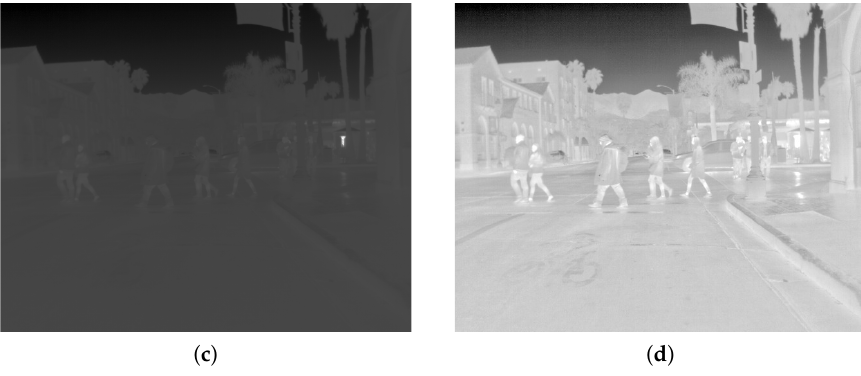
Figure 3. ( a ) Result 1 without multiscale guided filter enhancement. ( b ) Result 1 with multiscale guided filter enhancement. ( c ) Result 2 without multiscale guided filter enhancement. ( d ) Result 2 with multiscale guided filter